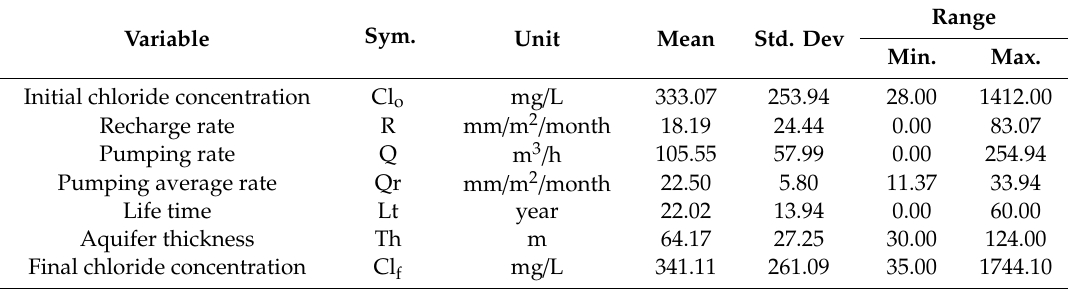
Table 2. Mean, standard deviation, and ranges of variables used to train the ANN